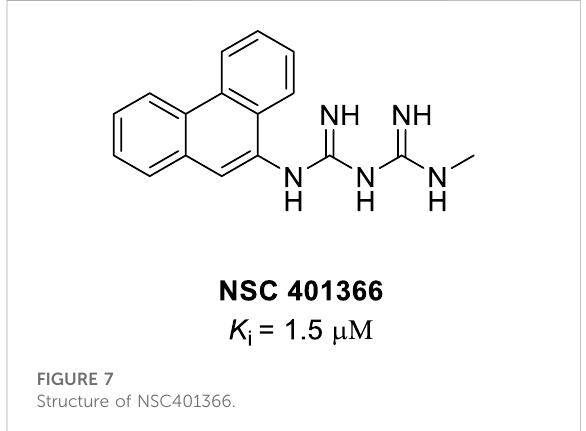
FIGURE 7 Structure of